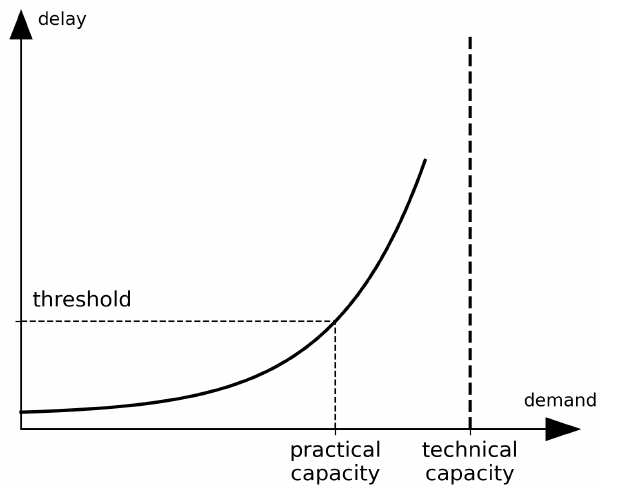
Figure 3. Concept of practical capacity, defined by a threshold of acceptable (average) delay. Table 1. Practical capacity for airport capacity planning in the